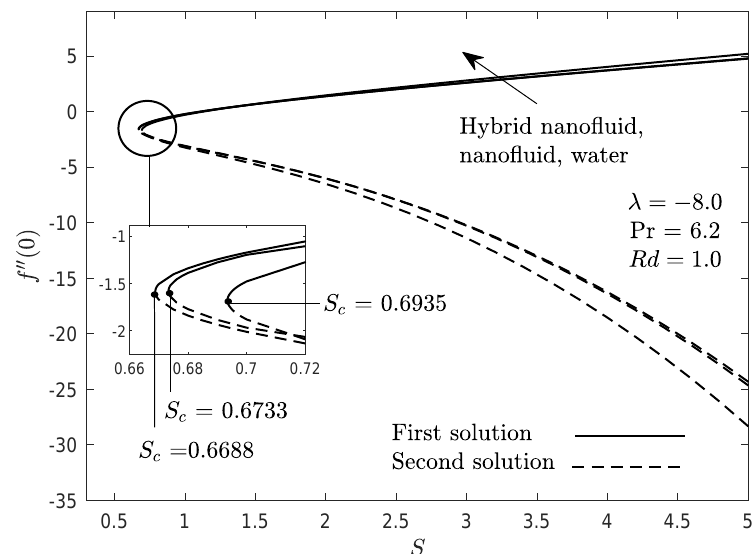
Figure 6. Impact of different fluids on surface shear stress, f (cid:48)(cid:48) ( 0 ) .